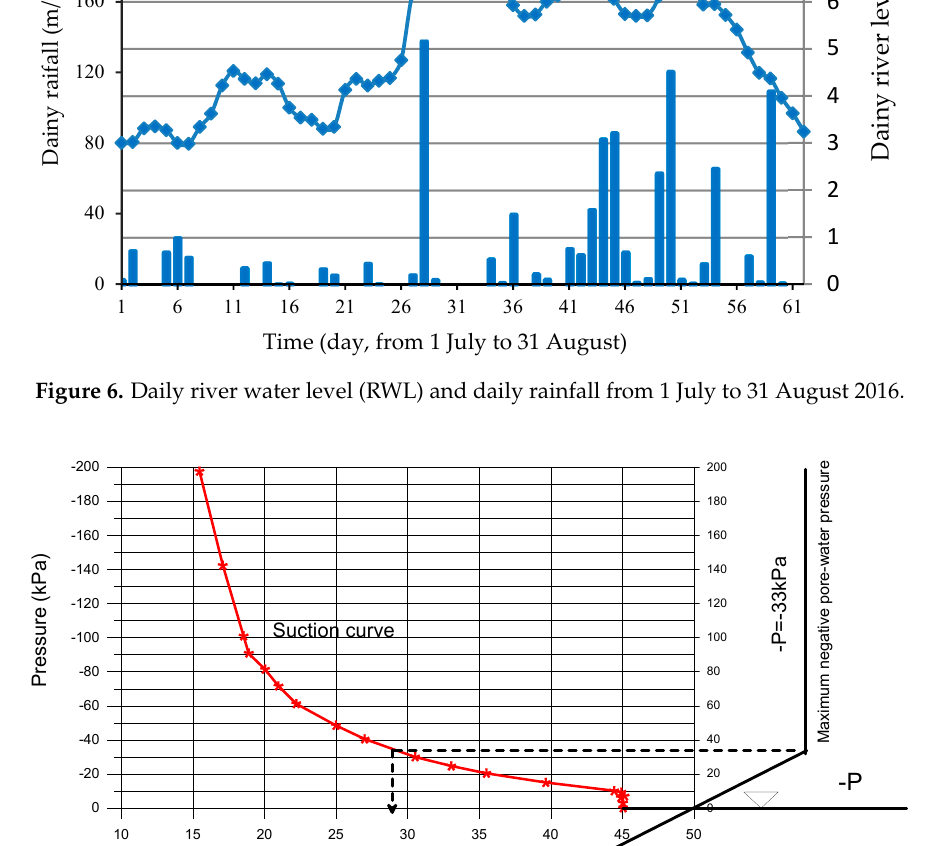
Figure 7. Calculation pore-pressure condition by saturation condition.